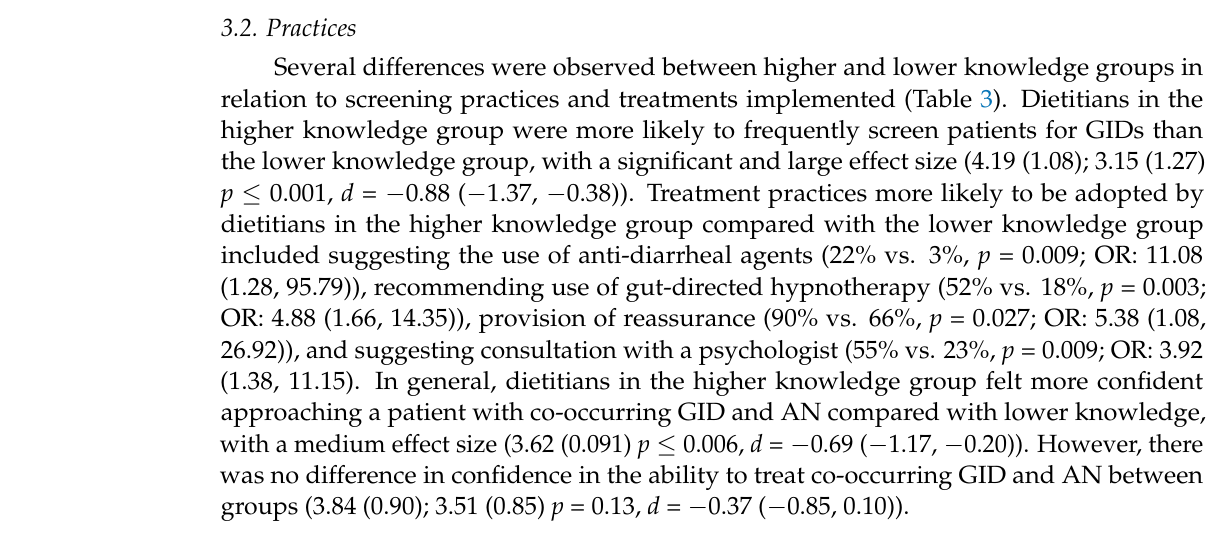
Table 3. Practices of dietitians with higher ( n = 31) and lower ( n = 39) knowledge of